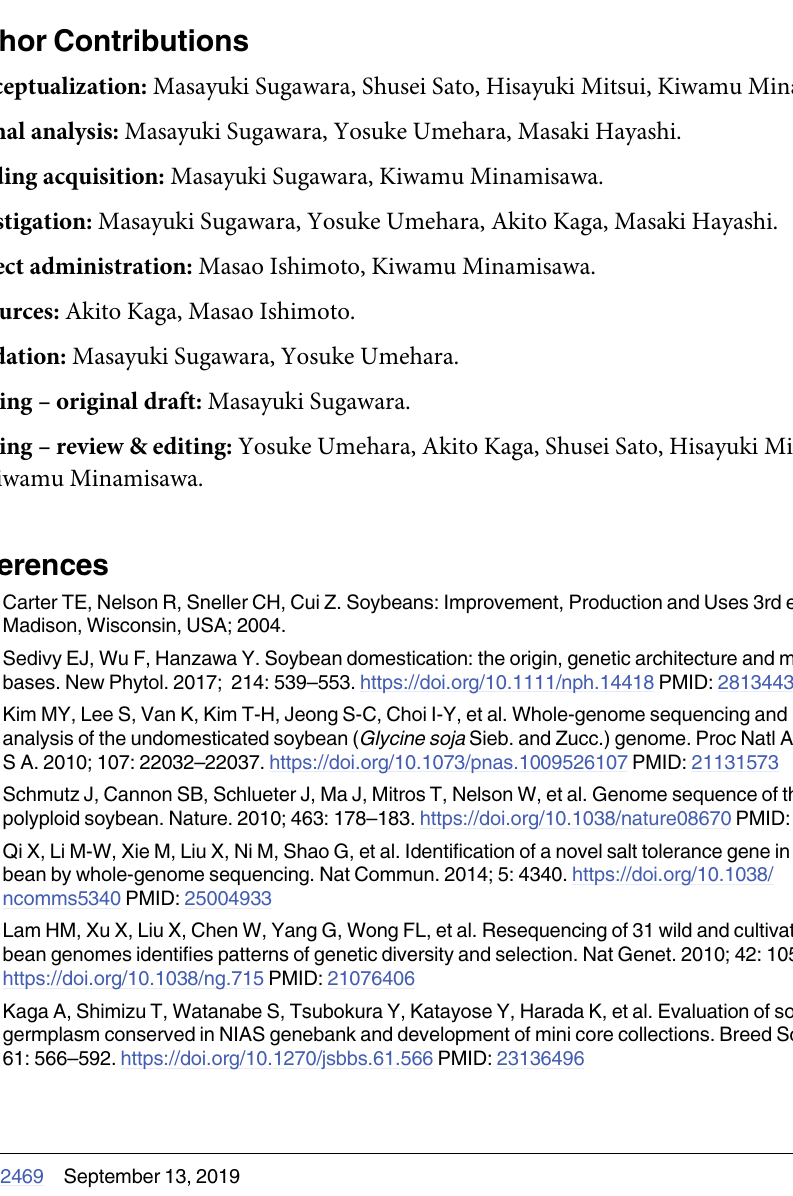
S2 Table. Bacterial strains and plasmids used in this study. S3 Table. Glycine soja accessions used for phenotyping, and the amino acid sequences of their Rj2 or rj2 protein. S4 Table. Soybean accessions used for SNP genotyping. S5 Table. Oligonucleotide primers used in this